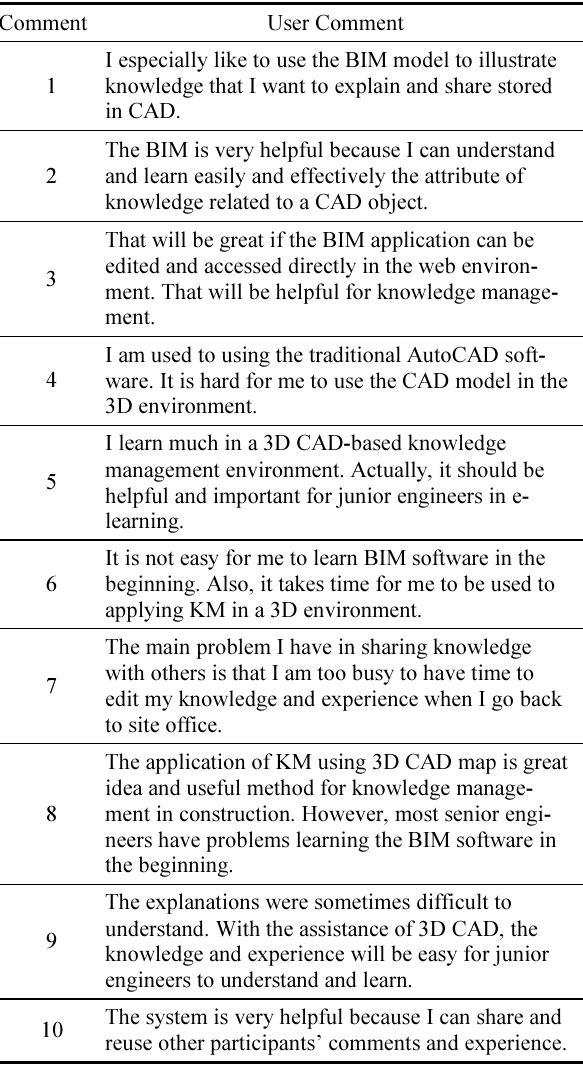
Table 2. Users evaluation comments